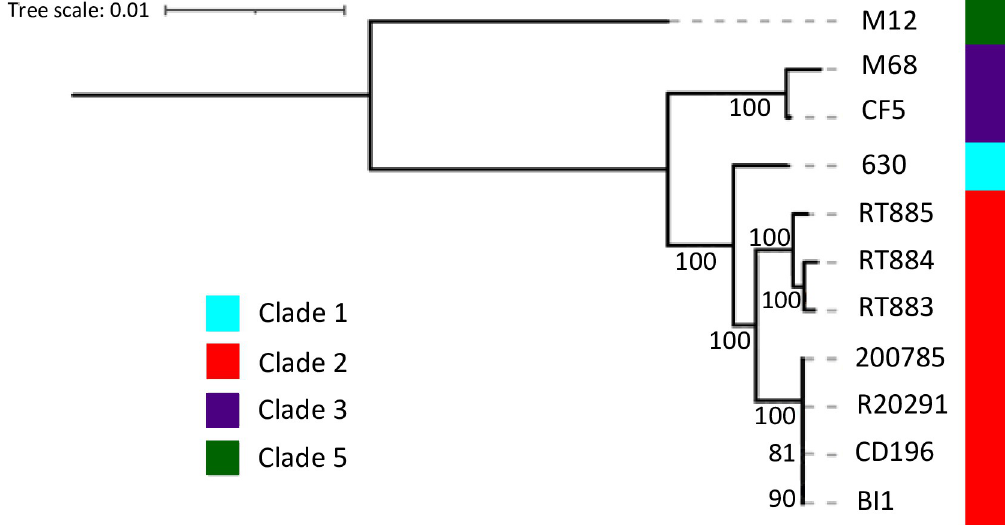
Fig 3. cgMLSA maximum likelihood phylogeny. The cgMLSA phylogeny tree based in 2.643 genes, containing 2,531,373 positions rooted by midpoint is represented. The colour strip represents the C . difficile Clades, where Clade 1, 2, 3 and 5 are represented by respectively the colours cyan, red, purple and green. The values in the branches correspond to the percentage of support (0 to 100%) based on 1000 ultrafast bootstrap replicates. The figure represents that RT883, 884, and 885 are very similar to each other and are related to other clade 2 reference strains (R20291, CD196, BI1, 2007855). Reference strains from clade 1 (CD630), clade 3 (M68, CF5), and clade 5 (M120) were also added for comparison